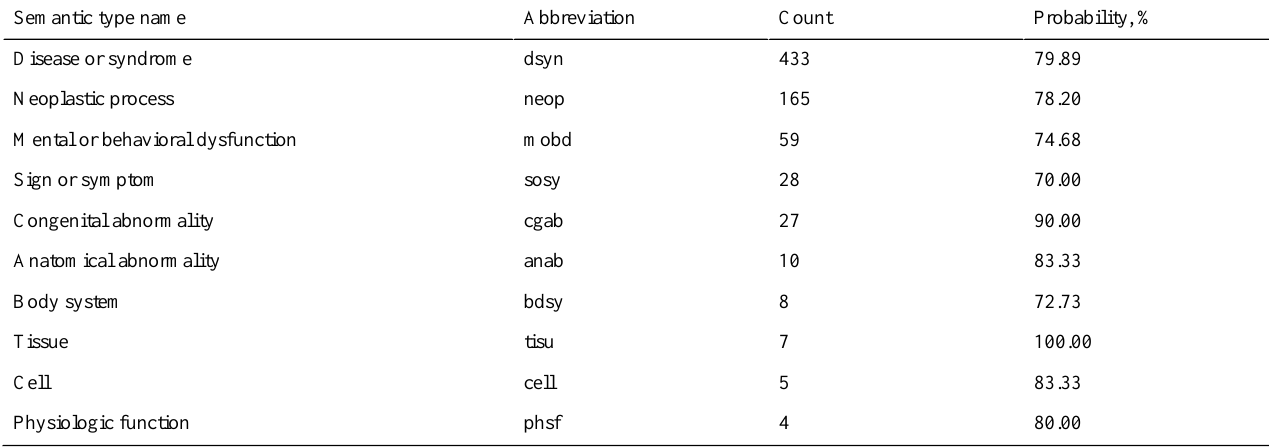
Table 2. The 10 most frequent Unified Medical Language System (UMLS) semantic types aligned with labeled observations in the training